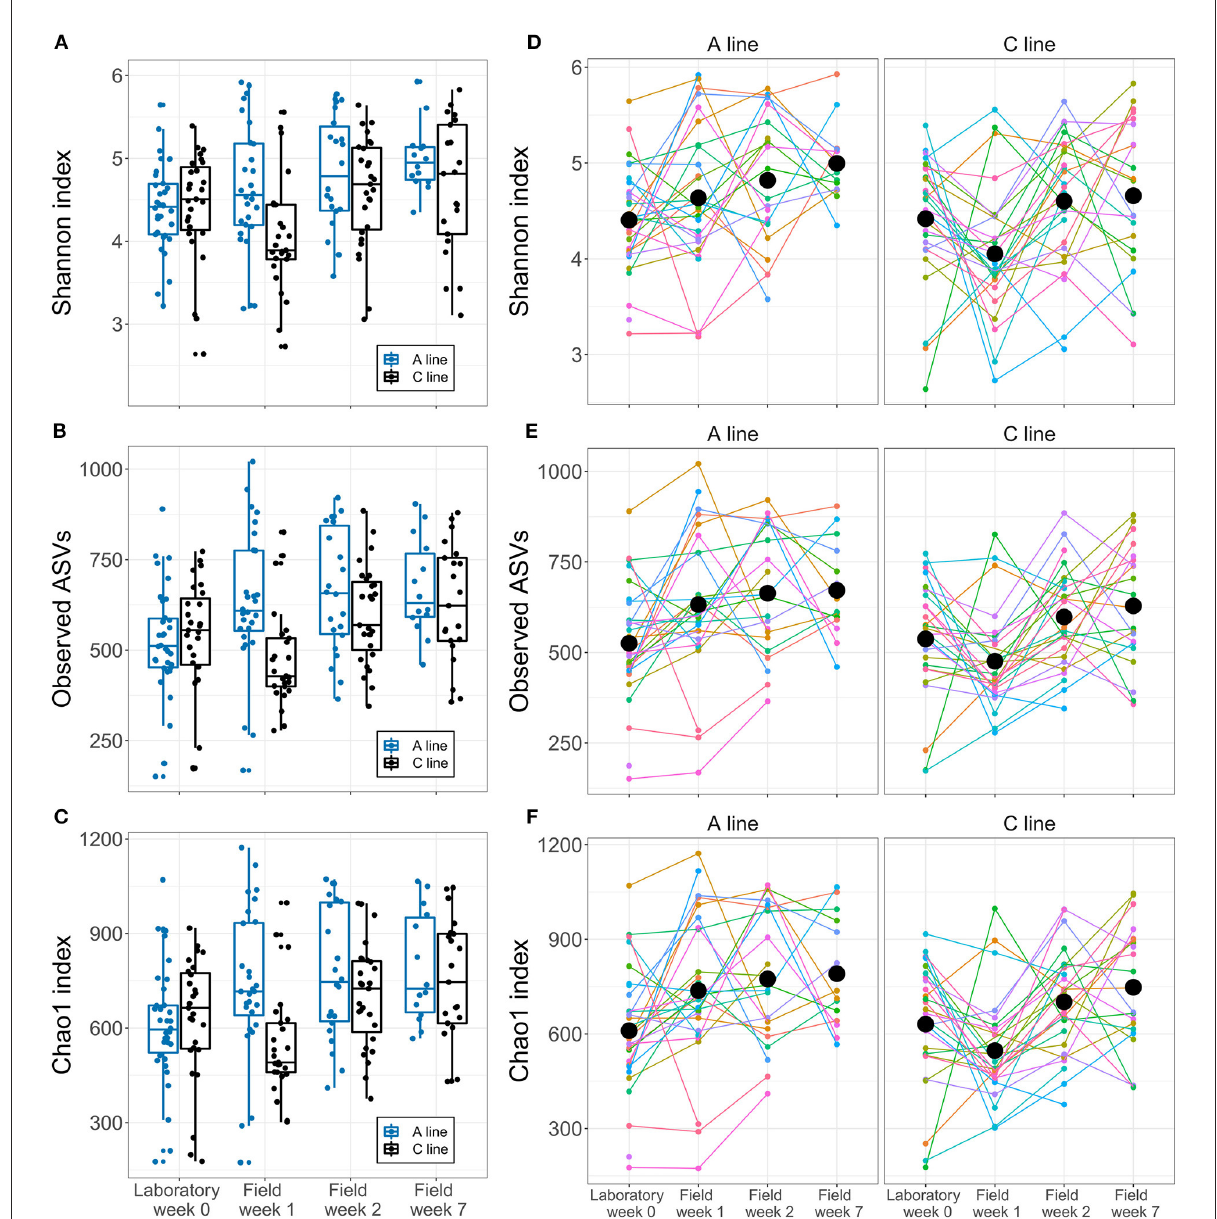
FIGURE3 Longitudinal changes in bank vole microbiota alpha diversity during the transition from laboratory to field. (A–C) Boxplots for each alpha diversity index at each sampling points (A line, blue; C line, black). Dots represent individual samples. (D–F) Within- and between-individual variation in alpha diversity. Colored lines represent different individuals, connecting samples collected from the same individuals at different times. Black dots represent the mean index of each selection line type within each sampling event.